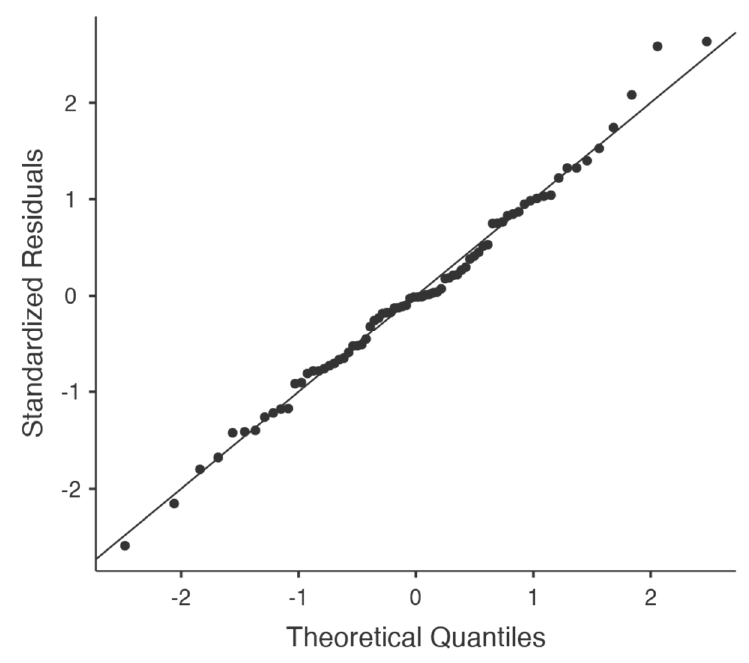
Figure A1. Q-Q plot for pectin yield extraction. Table A5. Shapiro–Wilk normality test for pectin yield extraction.